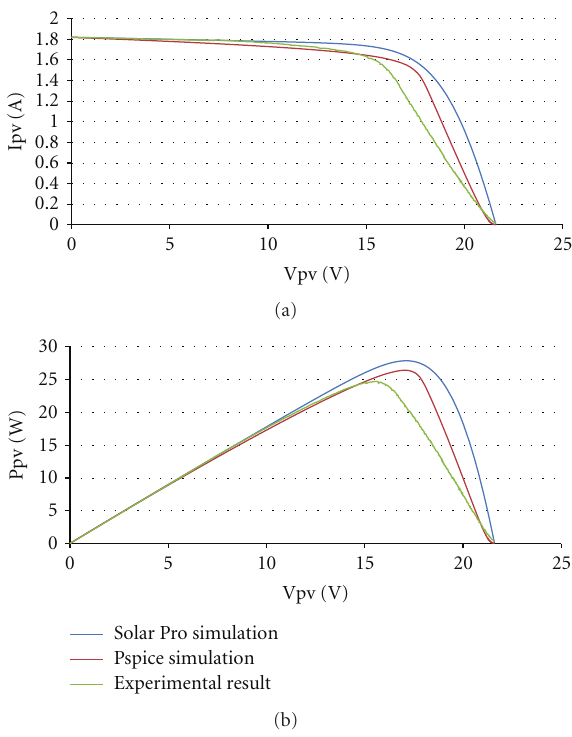
Figure 6: Comparison result for a single module, (a) I - V , (b) P - V output characteristic